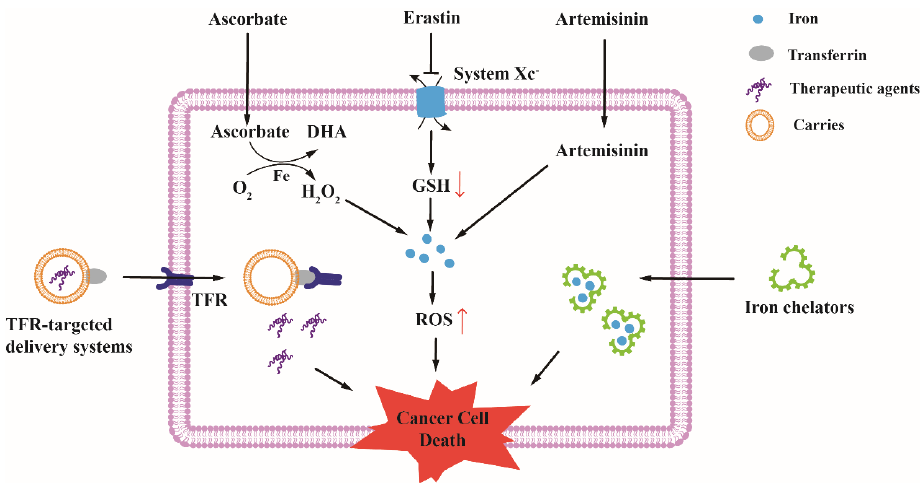
Figure 3. Therapeutic opportunities for cancer based on altered iron metabolism. TFR-targeted delivery systems can deliver drugs, proteins, nucleic acids, and viruses into cancer cells through binding to TFR, and these therapeutic agents induce cancer cell death through different mechanisms. Some potential anti-cancer drugs, such as Ascorbate, Erastin and Artemisinin, can disrupt redox homeostasis by intracellular high level of iron. H 2 O 2 produced from high-dose ascorbate react with excess intracellular iron to generate ROS; Erastin deplete GSH (red ↑ ) by inhibiting system X C− , subsequently, excess intracellular iron lead to an increase of ROS levels (red ↓ ); Artemisinin react with excess intracellular iron to promote the production of ROS. Excess cytotoxic ROS induce cancer cell death. Iron chelators decrease intracellular iron by binding iron with a high affinity. Lack of iron in cancer cells inhibits cell growth and proliferation, leading to cell death.